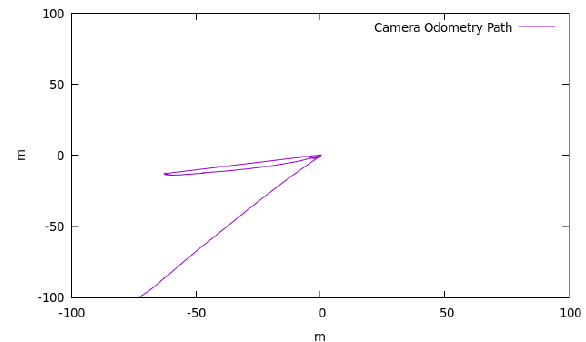
Figure 12. Zoomed out tracking path for free movement with non-calibrated